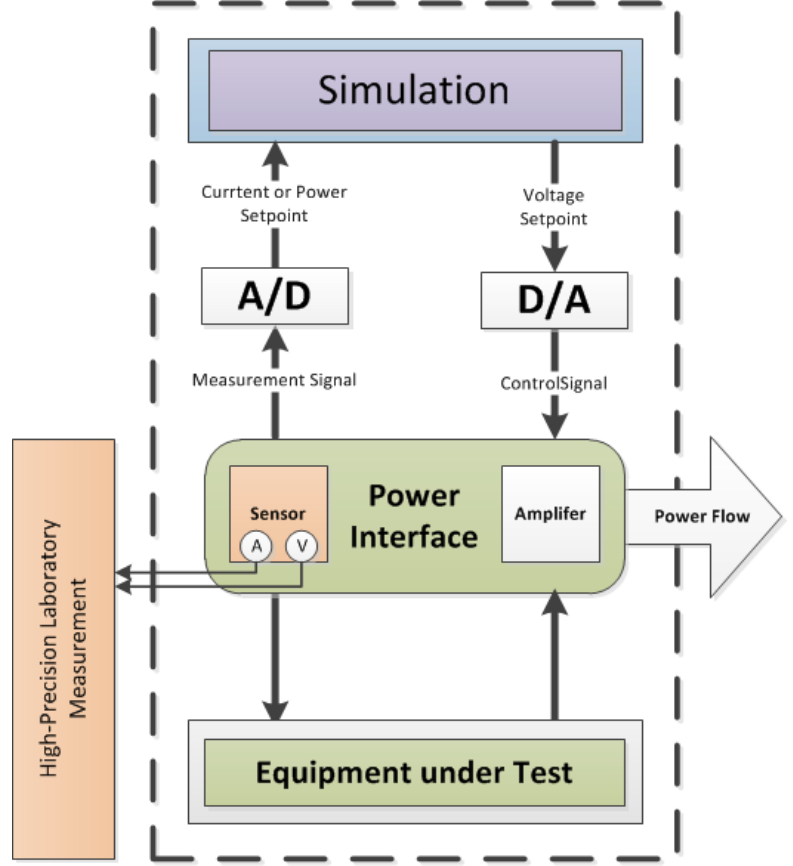
Figure 2. Generalised overview of a PHIL setup. The power interface applies a voltage value received from the simulation. The power interface exchanges electrical power with the EUT according to the applied voltage and the properties of the